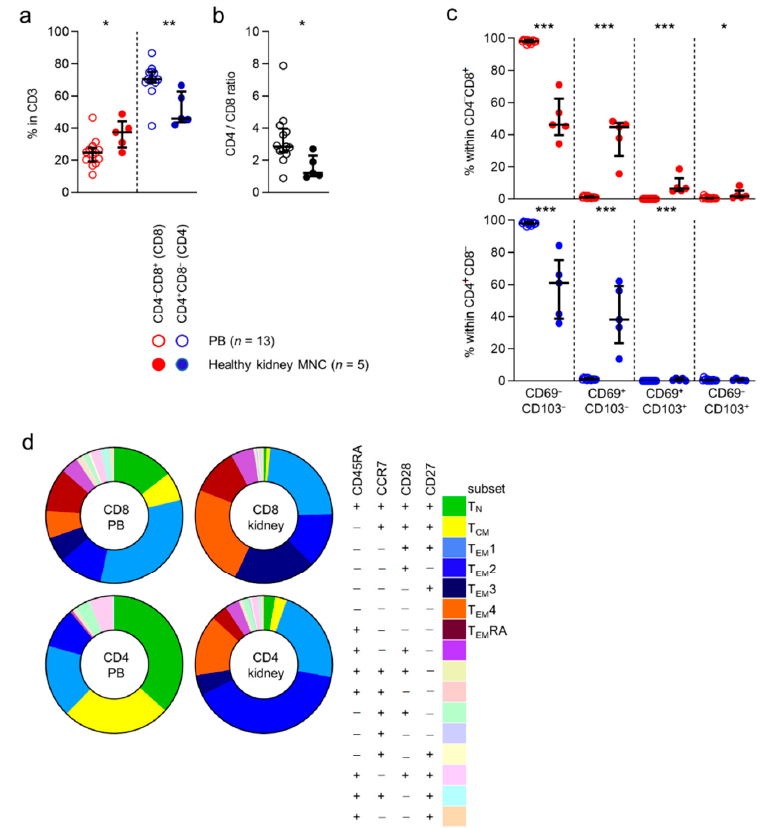
Figure 1. Kidney-derived T cells differ in CD4/CD8 distribution, contain TrM and have a different memory-profile than PB T cells. ( a ) Percentage of CD4 − CD8 + (CD8) and CD4 + CD8 − (CD4) T cells within CD3 + CD45 + single-cell live lymphocytes in peripheral blood (PB) and healthy kidney MNC (median with IQR in black). ( b ) CD4/CD8 ratio within PB and healthy kidney-derived T cells. ( c ) Distribution of CD69/CD103 based subsets within CD8 and CD4 T cells (median with IQR in black) derived from PB and healthy kidney. ( d ) Expression patterns of CD27, CD45RA, CCR7 and CD28 within CD8 and CD4 T cells from PB and healthy kidney (median). Mann-Whitney U-test was used for statistical comparison. Only significant p-values are displayed: * p < 0.05, ** p ≤ 0.01, *** p ≤ 0.001.